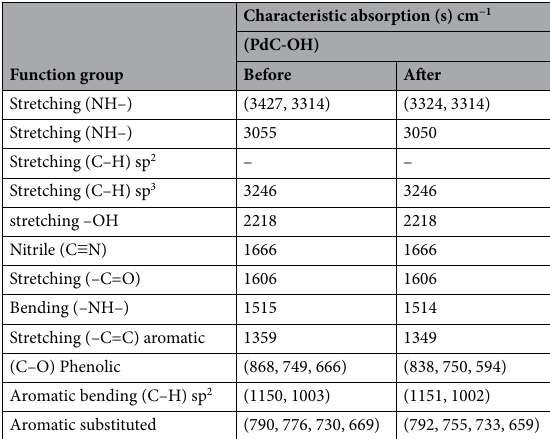
Table 12. Characteristic peaks before and after immersion in1M HCl in presence of the PdC-OH derivative for 24 h on the carbon steel surface at 25 °C.